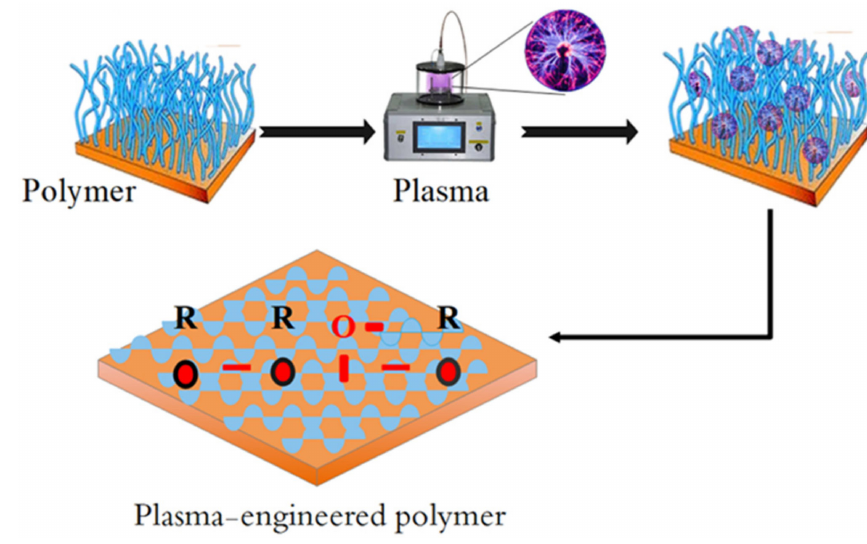
Figure 2. Plasma-engineered